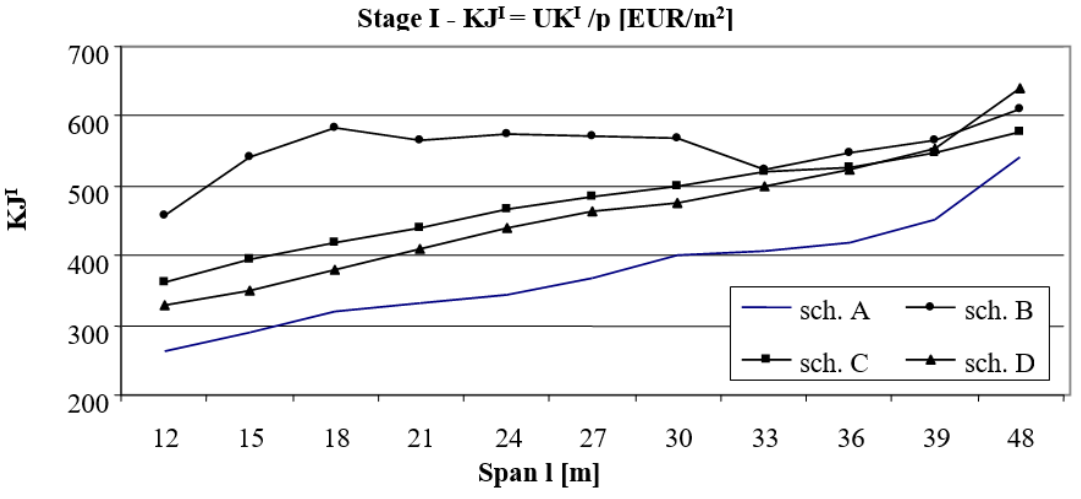
Figure 6. KJ I unit cost of creating the UK I structure per 1 m 2 of the built-up area [EURO/m 2 ].